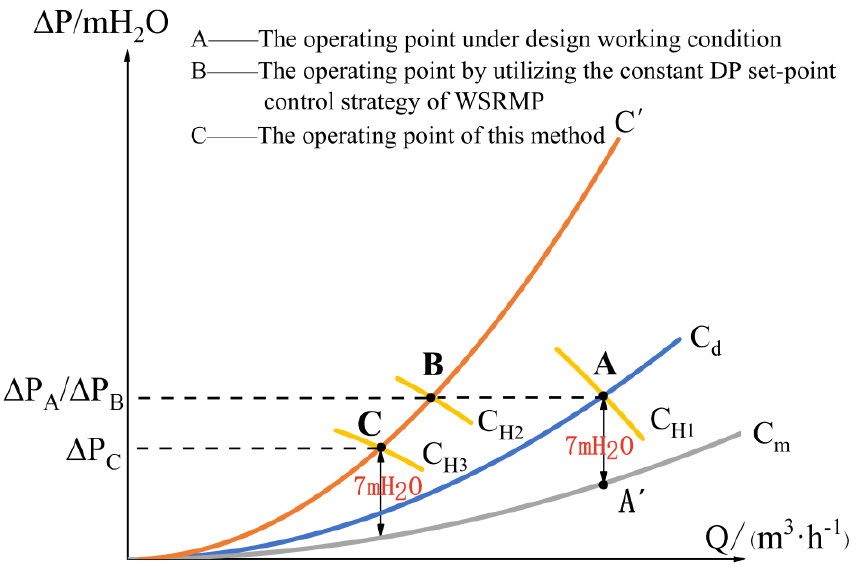
Figure 7. Schematic diagram of analysis process. C’ represents the characteristic curves of the actual working condition pipeline; C d represents the characteristic curves of the design working condition pipeline; and C m represents the characteristic curves of the equivalent main pipe.